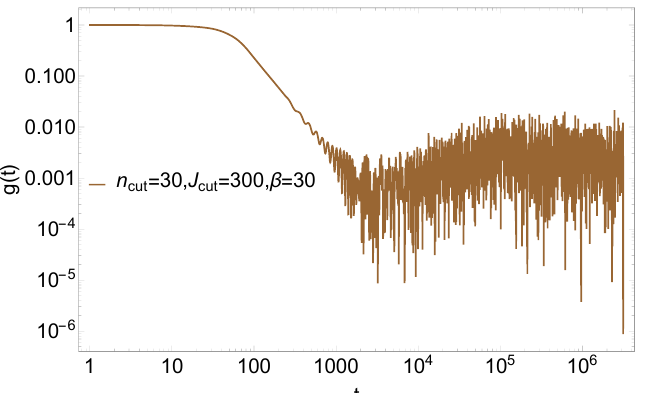
Figure 10. SFF for 3 d Rindler normal modes with n cut = 30 , J cut = 300 , β = 30 . Other parameters are fixed to ξ = 20 , R = 2 , a = 1 0